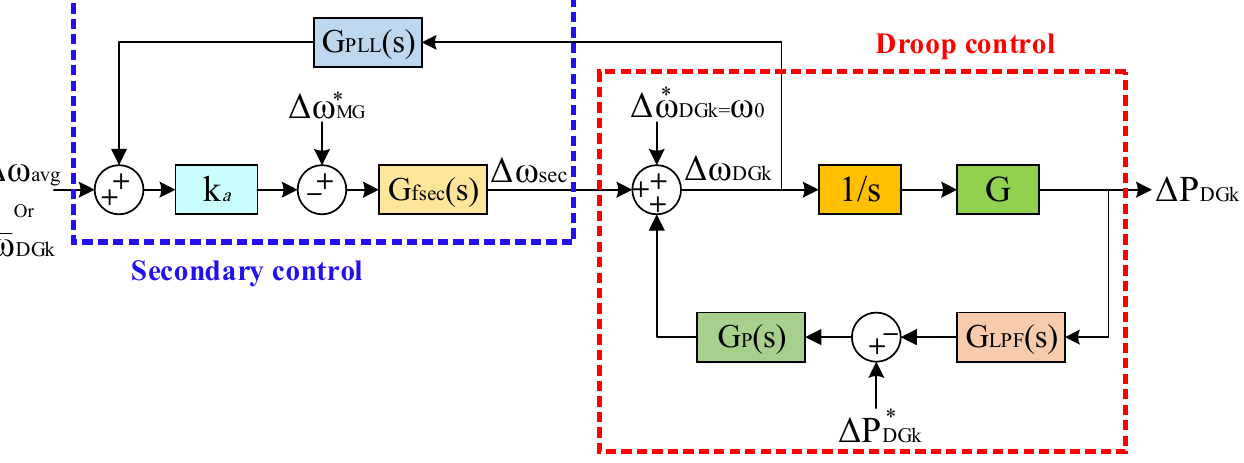
Figure 3. Small signal model of frequency distributed controller for DG k .